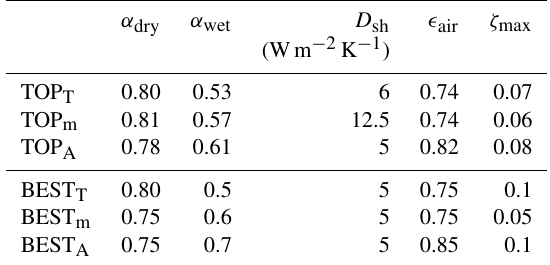
Table 4. Parameter combinations averaged over the 10 simula- tions with lowest RMSE for monthly snow area TOP A , Greenland borehole temperature TOP T , and Greenland mass balance TOP m , and the single simulation with the lowest RMSE for each metric (BEST X